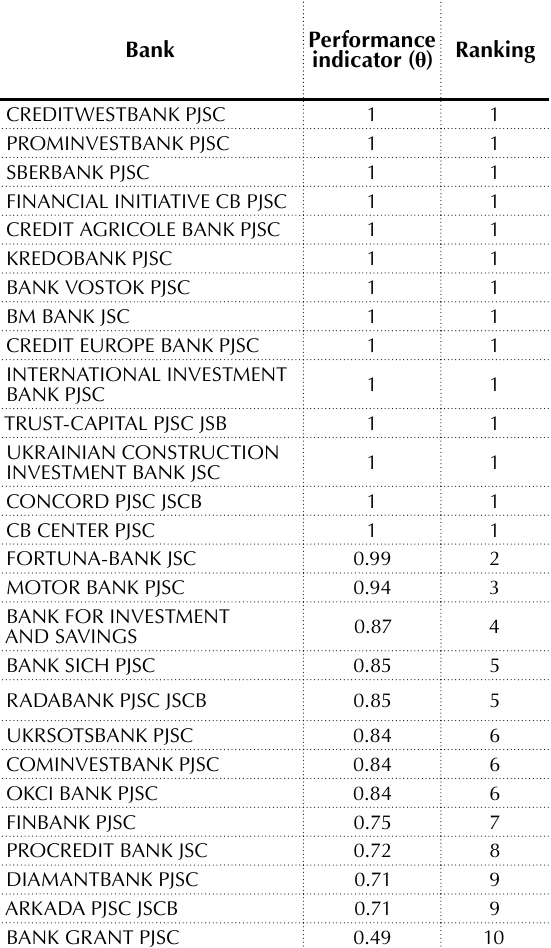
Table 1. Performance indicators and the